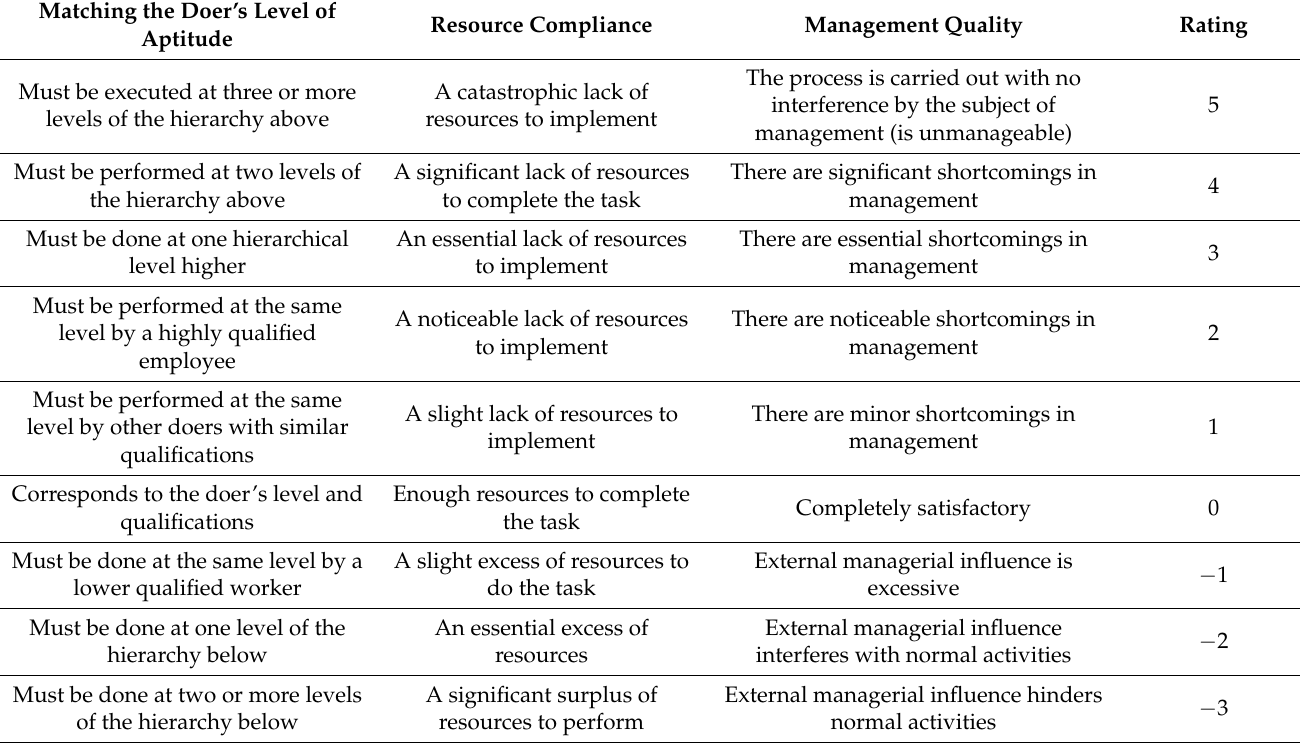
Table 2. A Scale for assessing the employees’ subjective attitude to the tasks.